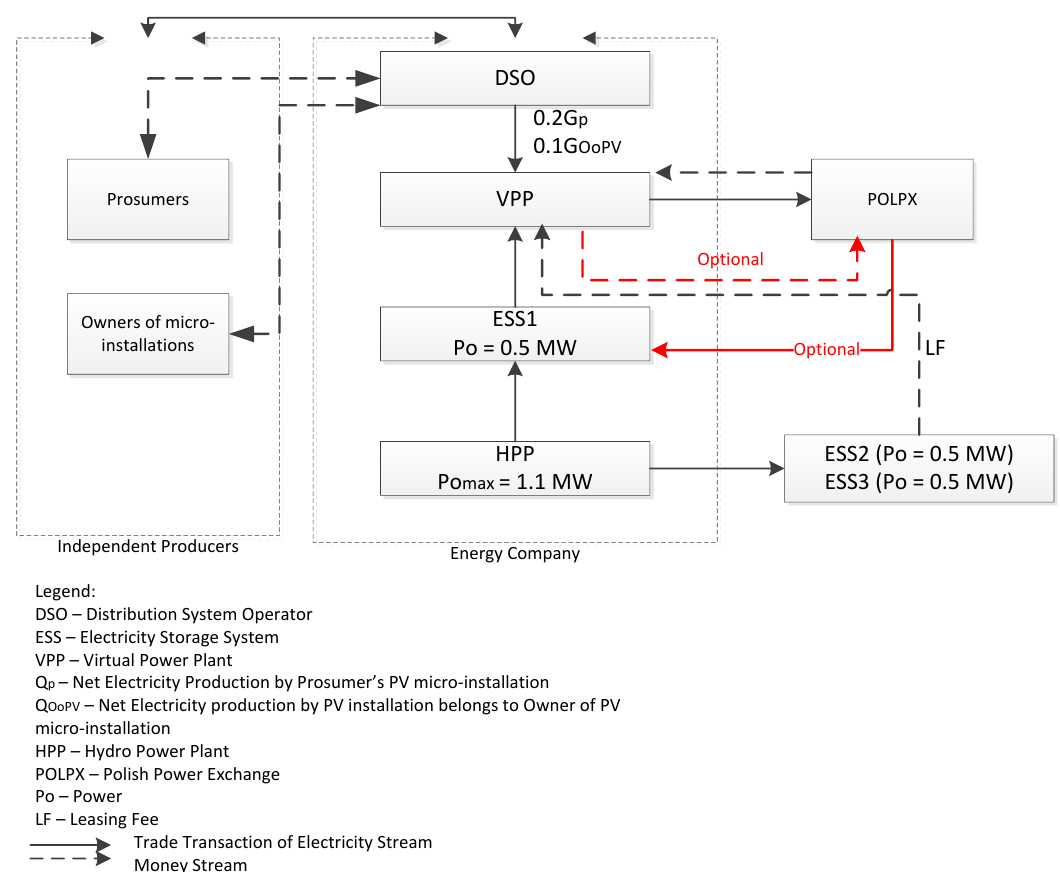
Figure 2. VPP partners, and physical and financial streams between them.